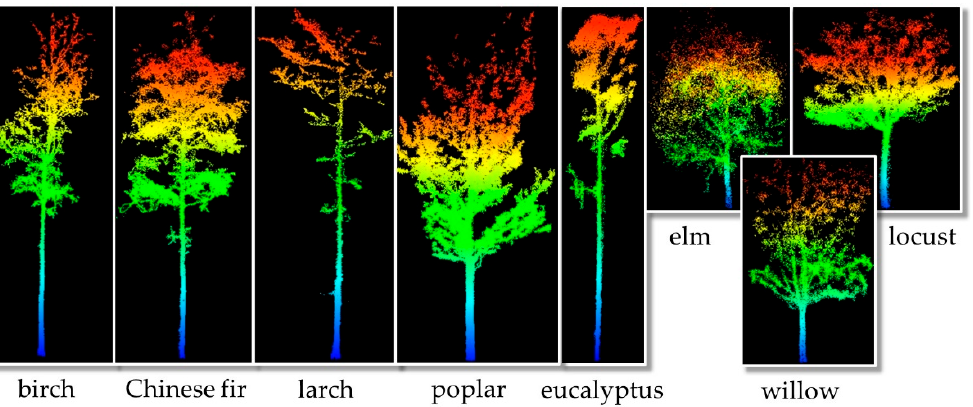
Figure 3. A sample of the individual tree point clouds of eight tree species used in this experiment.